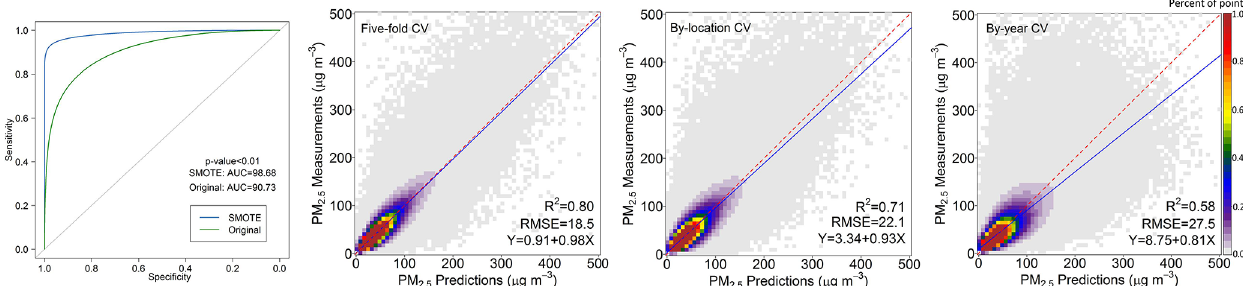
Figure A2. Model evaluation of the first-stage model trained with the original dataset and the SMOTE-resampled dataset in fivefold cross- validation (CV) and scatter plots comparing the ground measurements and model predictions in fivefold CV, by-location CV, and by-year